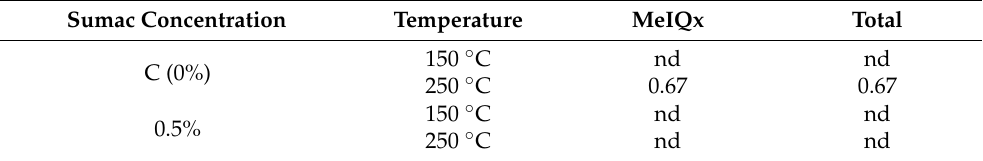
Table 4. HAA levels in the meatballs with and without sumac cooked at different temperatures (ng/g). Sumac Concentration Temperature MeIQx